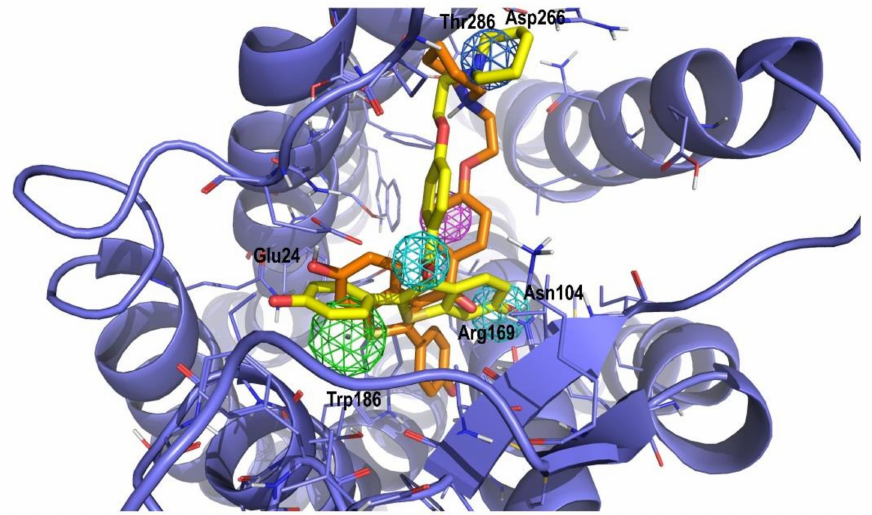
Figure 2. Superposition of the prospective bound conformation of raloxifene onto the B2 receptor (orange) and the matching structure of raloxifene (yellow) from the virtual screening process. The 3D structure of the B2 receptor was constructed by homology modeling and reported previously [27]. Color spheres represent the pharmacophore points characteristic of the ligands binding to B2 receptor: dark blue represents a positive charge moiety; magenta a hydrogen bond accepting center; light blue a hydrogen bond donor/acceptor center; green an aromatic/lipophilic